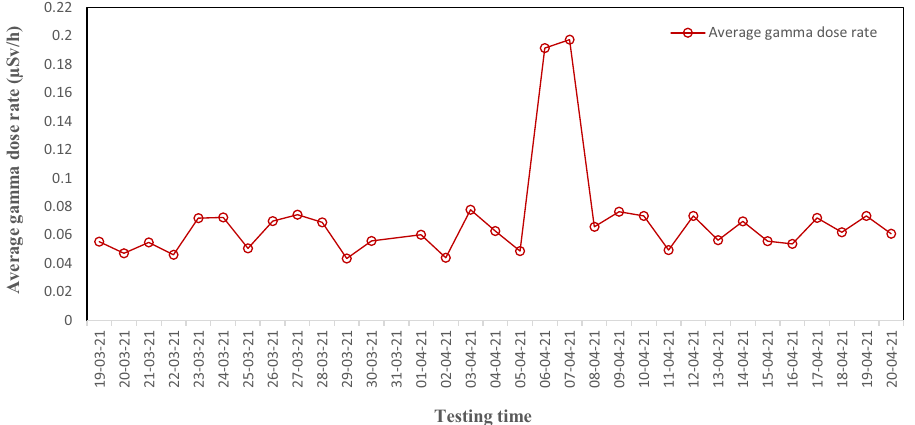
Figure 17. The measurement of the average gamma dose rate during the test period from March 19, 2021, to April 20,